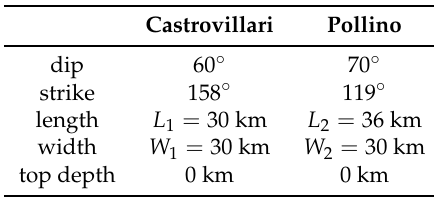
Table 1. Fault parameter used in this